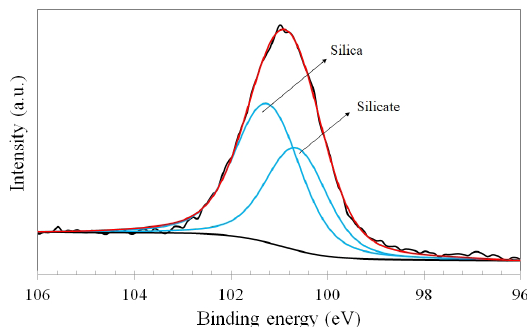
Figure 7. XPS Si 2p high resolution spectrum of the BO-20